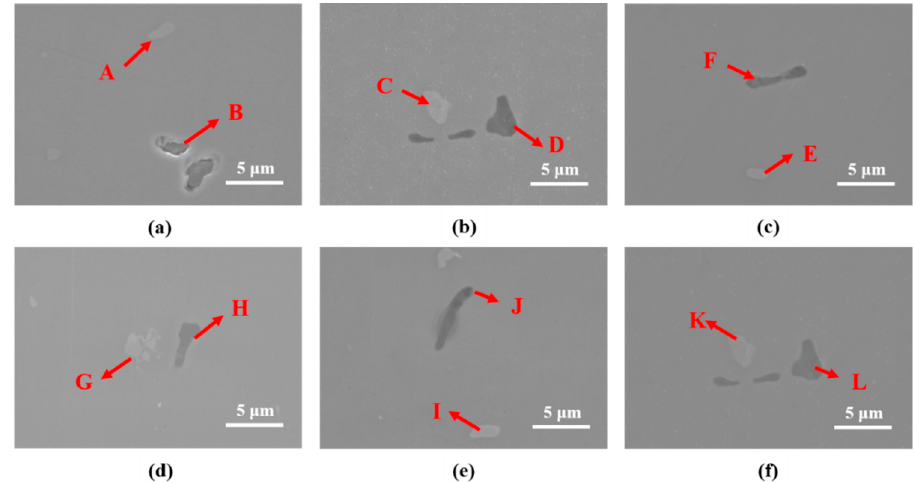
Figure 5. SEM observation results for various heat-treated specimens (forging A: ( a – c ), forging B: ( d – f )). ( a ) As-received A, ( b ) RA120, ( c ) IA120, ( d ) as-received B, ( e ) RB120, and ( f ) IB120. Table 4. EDS analysis results for specimens as-received A, RA120, and IA120, as shown in Figure 5a,c,e, respectively. at.%